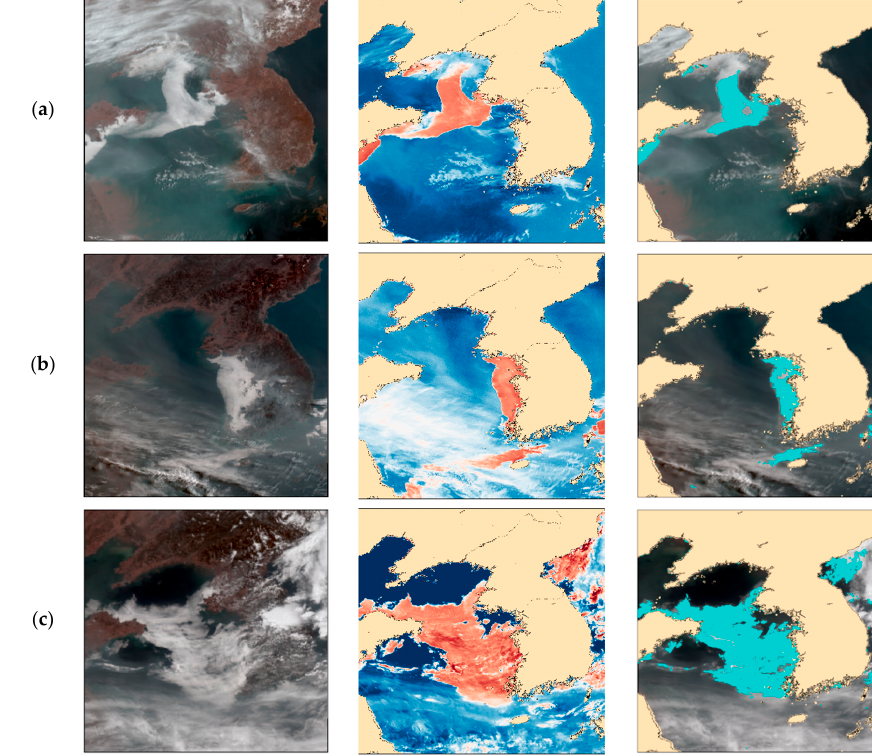
Figure 14. Cases of absence of SWIR band observation. Results for sea fog detection using the proposed algorithm on ( a ) 11 March 2017 at 01:20 UTC, ( b ) 30 April 2017, at 22:30 UTC, and ( c ) 1 June 2017, at 02:20 UTC.